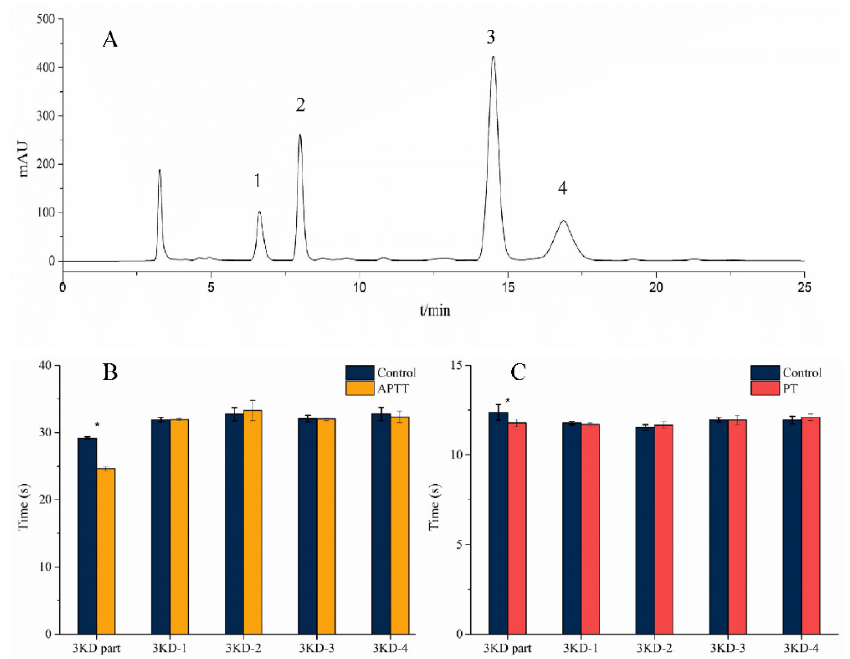
Figure 1. ( A ) Prep-HPLC separation map of the 3-kD part. Labels 1, 2, 3, and 4 are the target peaks. ( B ) The results of the APTT test (*: p < 0.05). ( C ) The results of the PT test (*: p < 0.05).